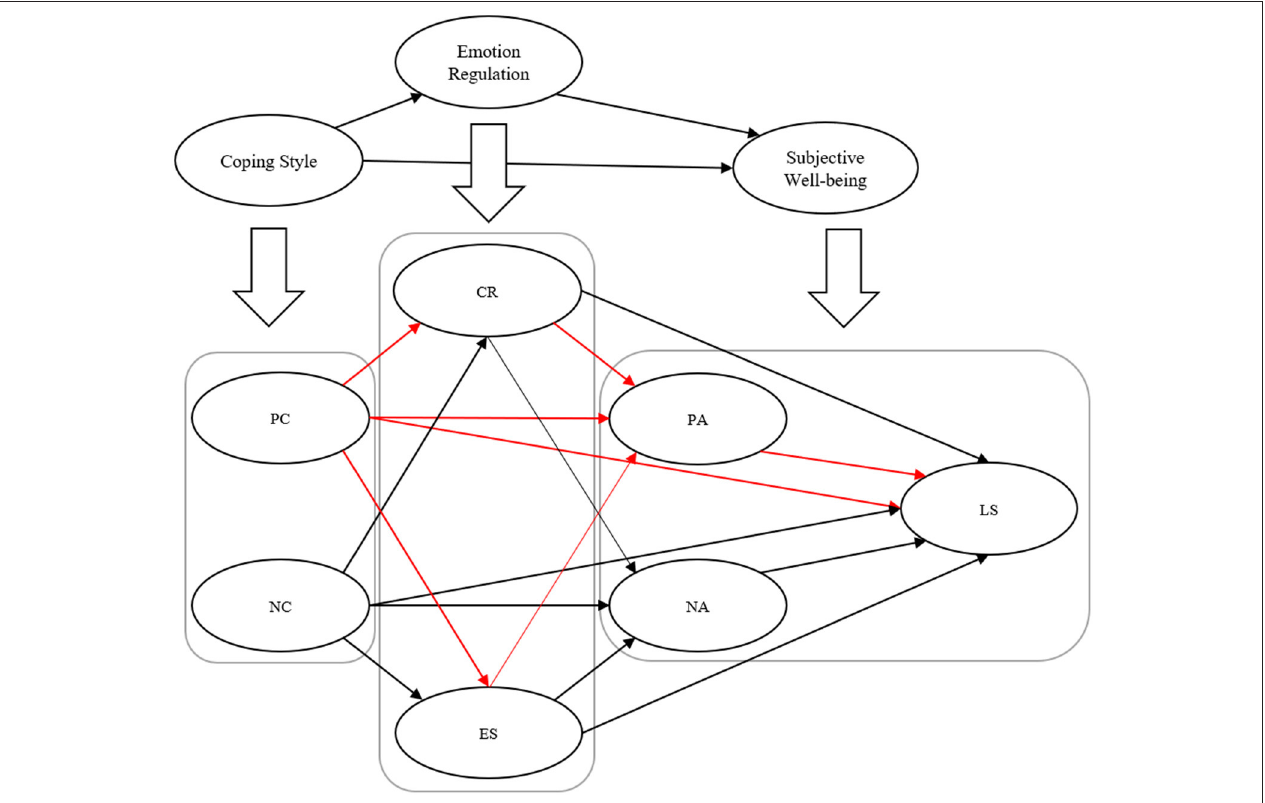
FIGURE 1 | The proposed model in our study. Positive paths are marked in red. PC, positive coping; NC, negative coping; CR, cognitive reappraisal; ES, expression suppression; PA, positive affect; NA, negative affect; LS, life